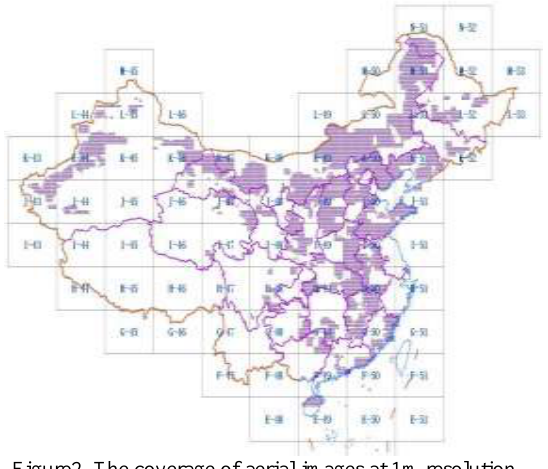
Figure2. The coverage of aerial images at 1m resolution 3.2.2 Satellite Orthophoto Data Production: We have produced 8713 mapsheets satellite orthophotos using SPOT5, P5, ALOS, IKONOS satellite image data. The coverage area of satellite orthophoto data is shown in Figure3.